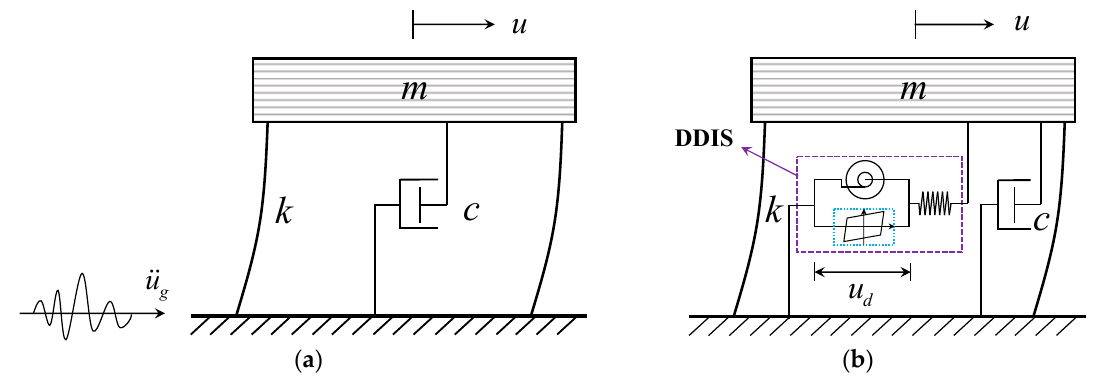
Figure 4. Mechanical model of the single-degree-of-freedom (SDOF) frame structure ( a ) without and ( b ) with the DDIS.